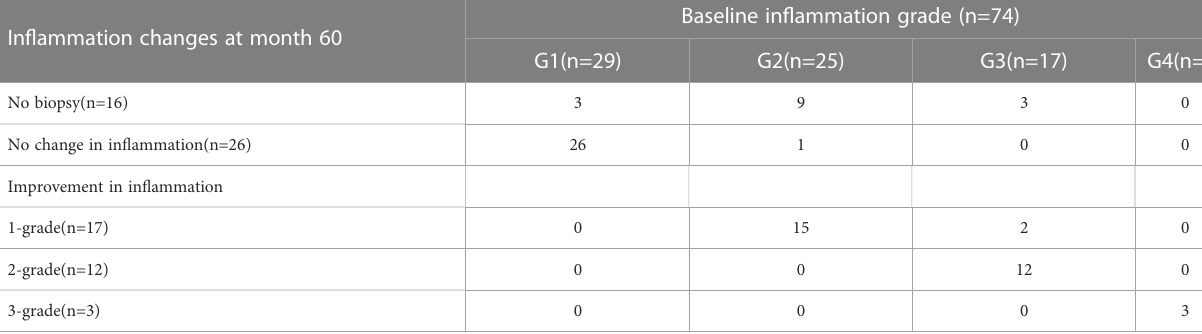
TABLE 4 In fl ammation changes in HBeAg-positive patients received 60 months of NAs therapy according to Scheuer scoring system.